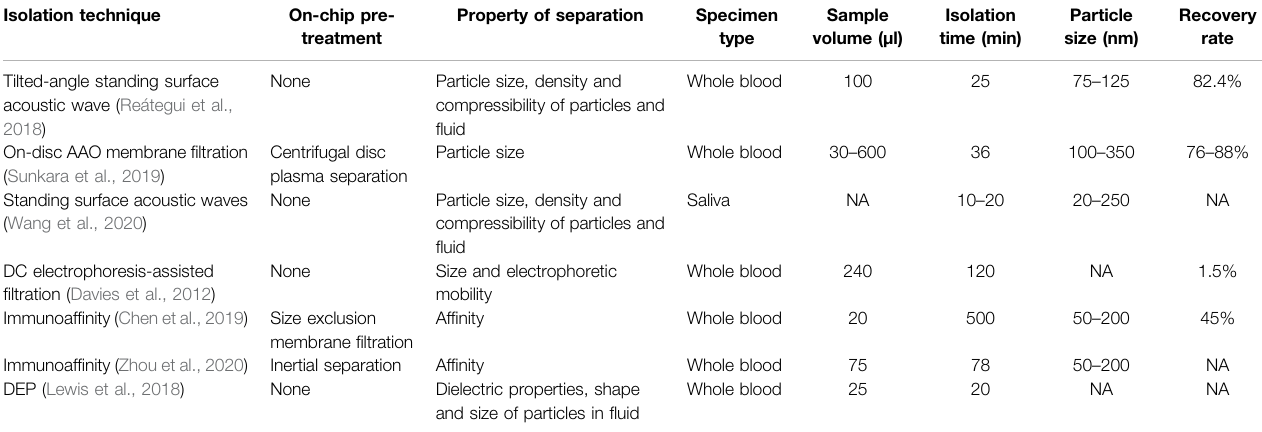
TABLE 2 | Platforms for isolating exosomes directly from bodily fl uid samples that are routinely collected in clinical settings. Isolation technique